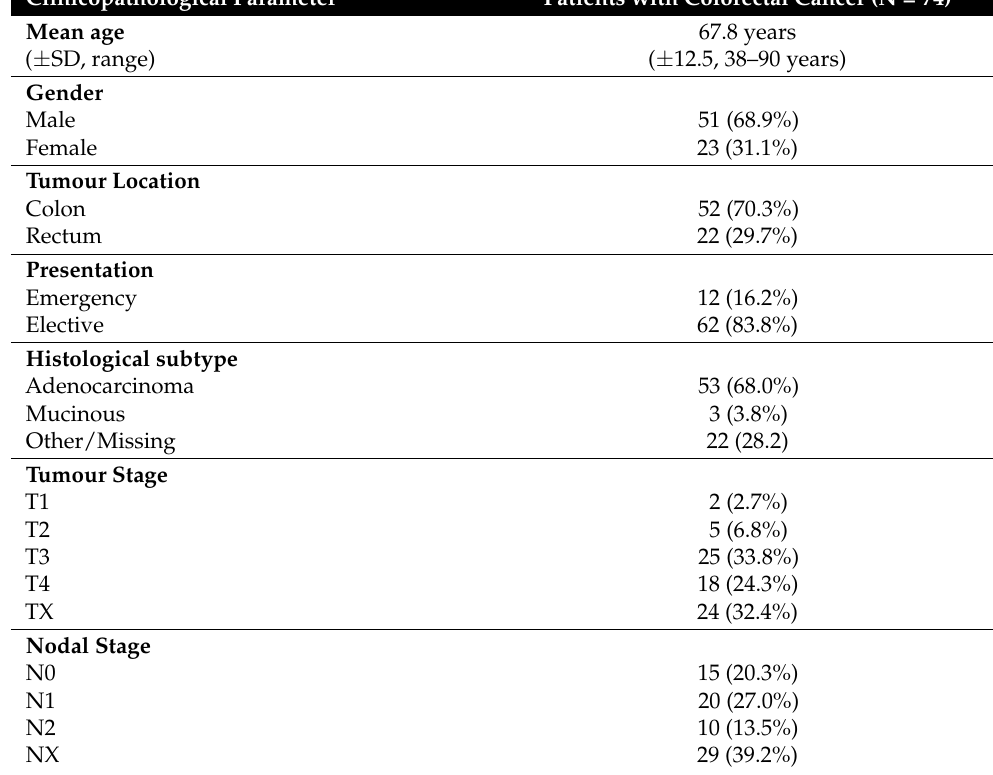
Table 1. Patient demographics, clinicopathological, and survival data for the 74 patients with colorectal cancer included in this